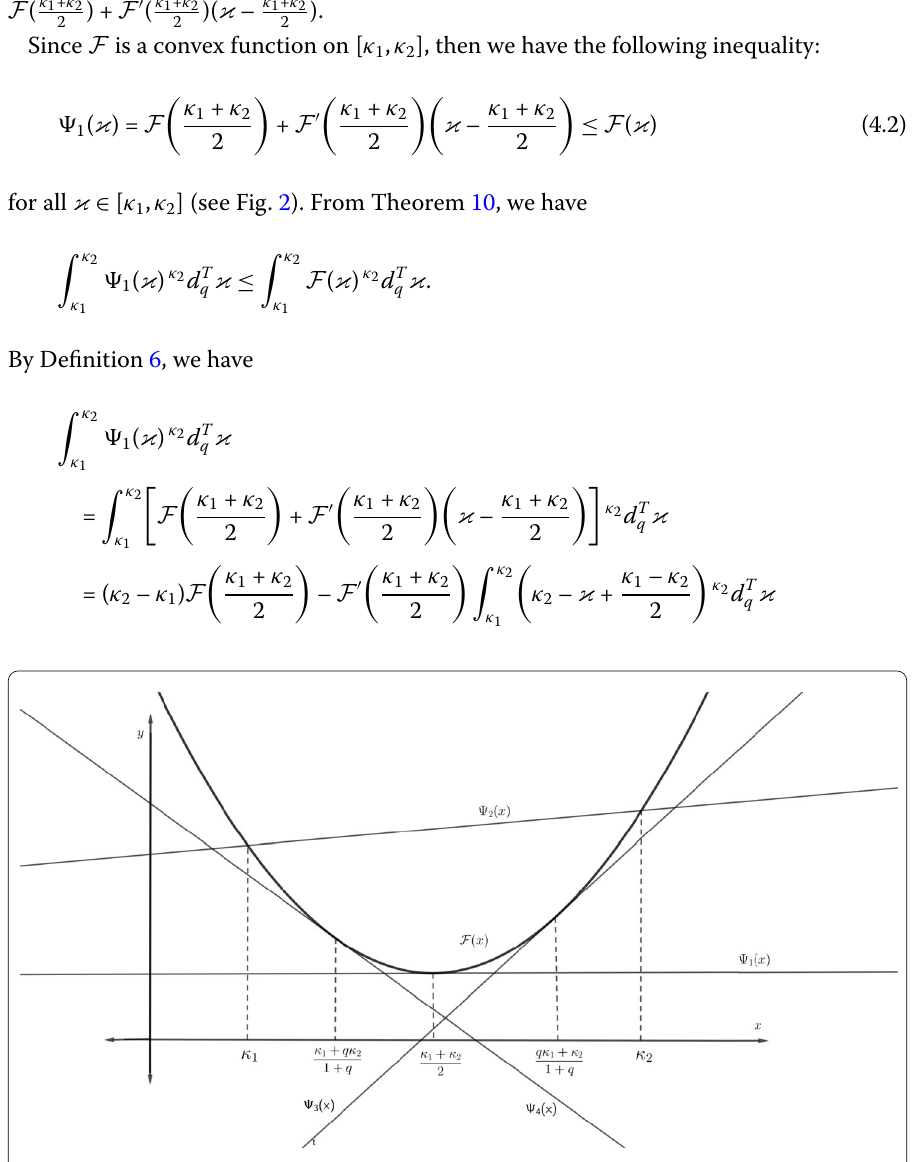
Figure 2 Graphs of a convex function F and some tangent